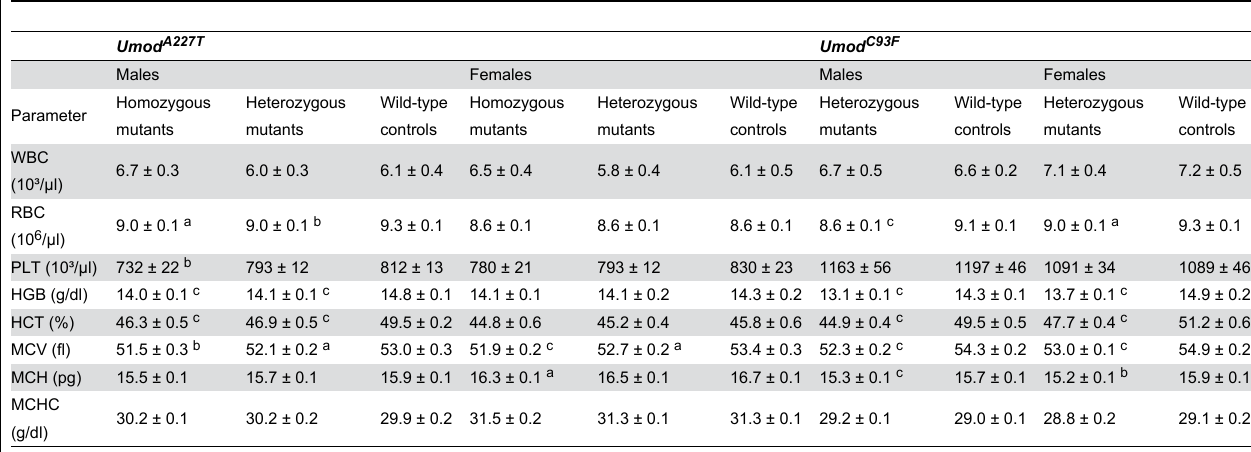
Table 1. Hematological analysis of the lines Umod A227T and Umod C93F .